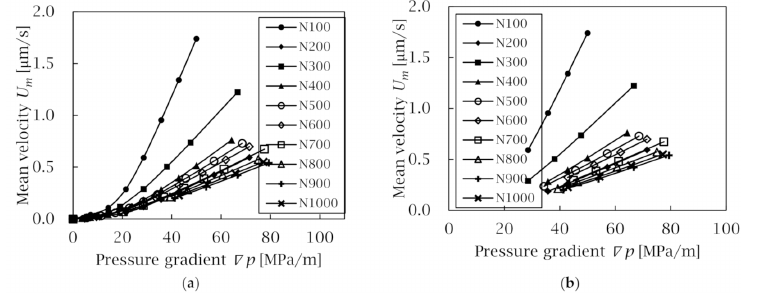
Figure 10. Numerical results for Bingham fluid flow simulation at varying pressure gradient ∇ p and structure size N . The resolution ratio is R = 1.0. ( a ) Relationship between mean velocity and pressure gradient at varying structure size. ( b ) Same results shown in ( a ), but pressure gradient range changed to keep only 4 data points in the linear form regime. The index N in the figure represents the structure size.